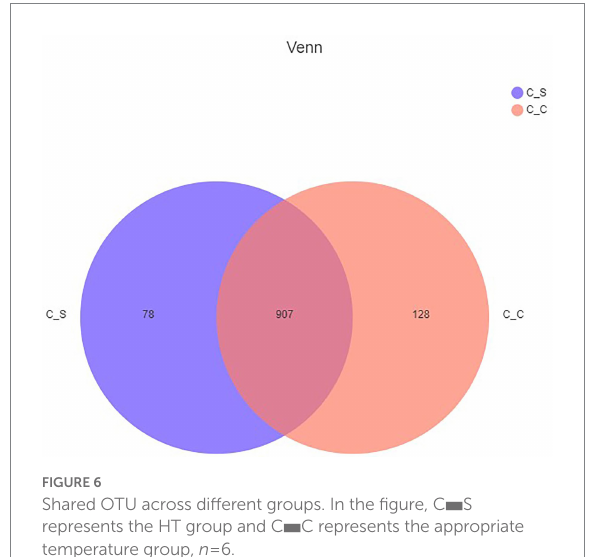
FIGURE 8 PCA of the cecal microflora of rabbits. In the figure, C ▬ S represents the HT group and C ▬ C represents the appropriate temperature group, n